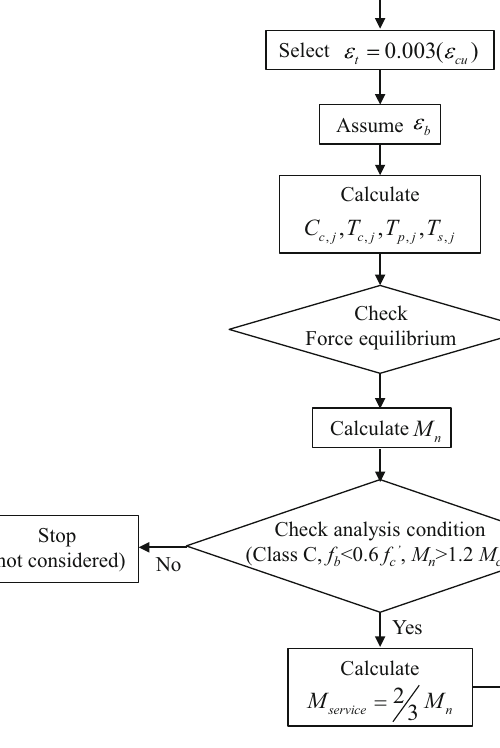
Fig. 5 Computational procedures of flexural